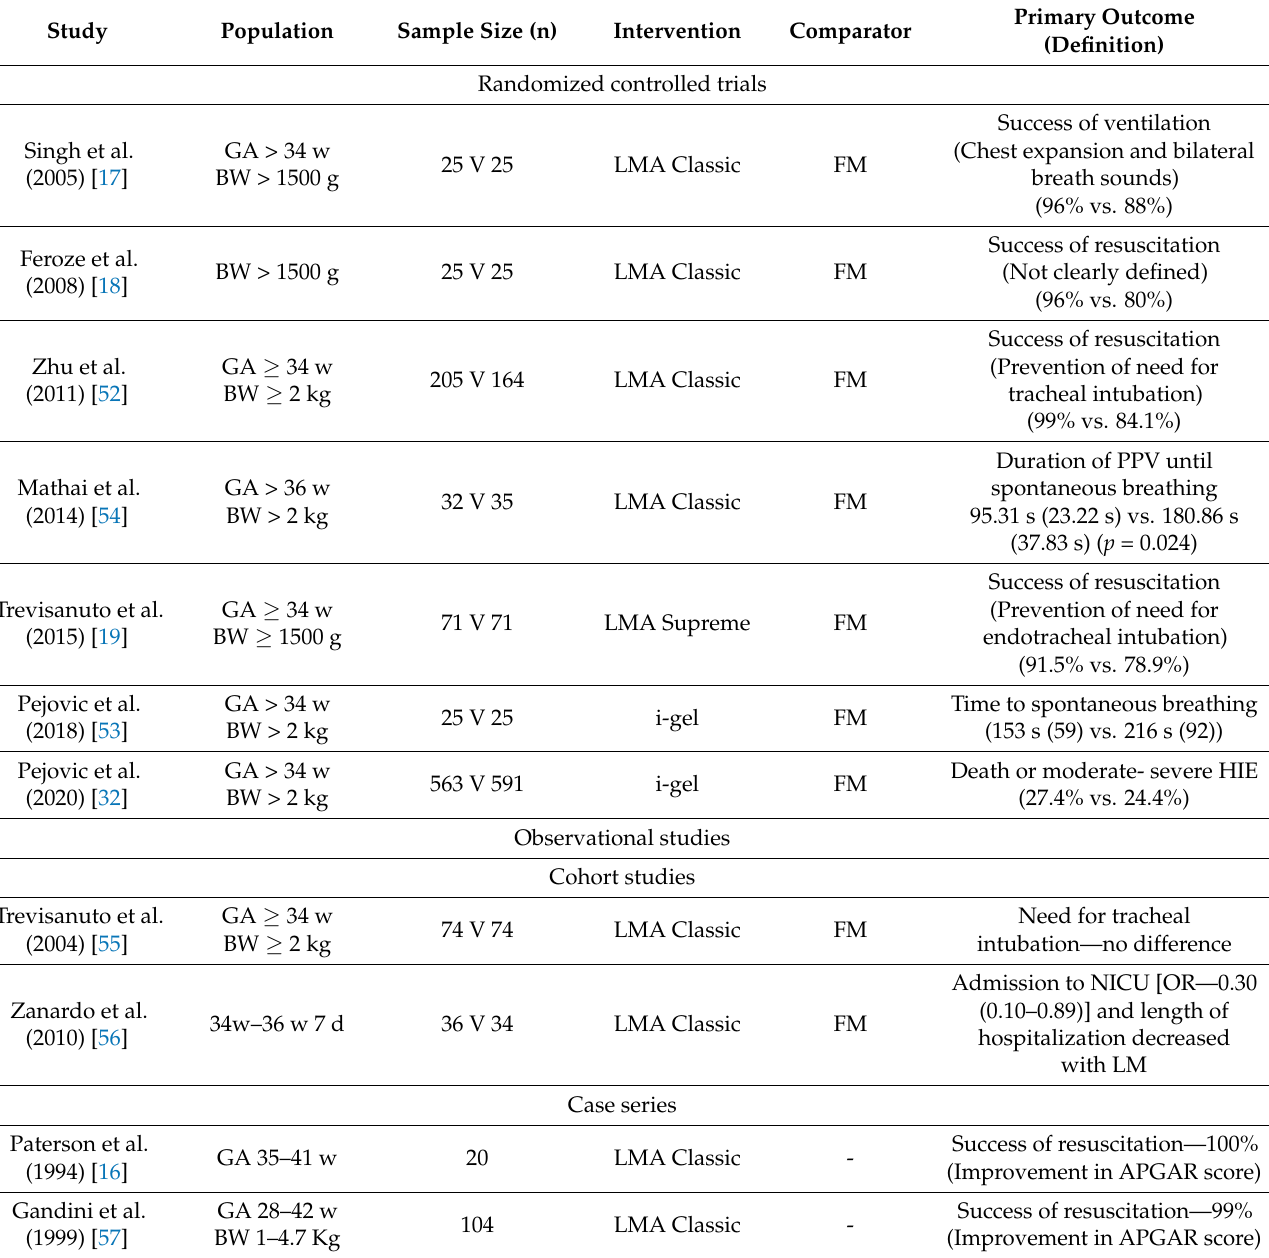
Table 1. Studies comparing LM with FM as the primary PPV